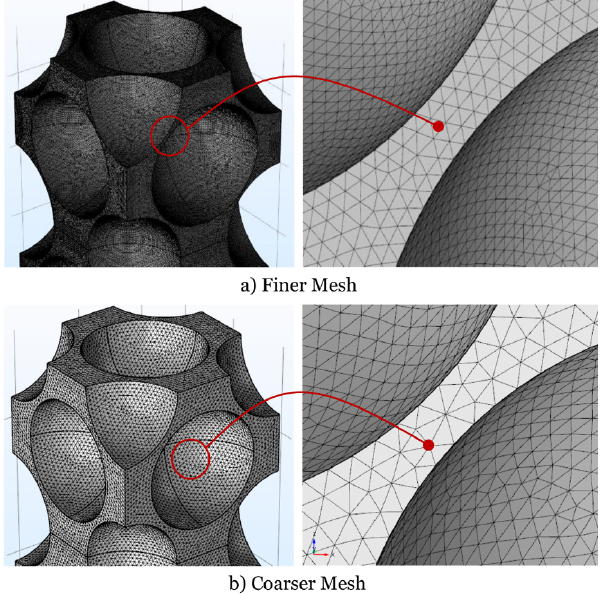
Figure 8. Mesh details: ( a ) Finer mesh and ( b ) Coarser